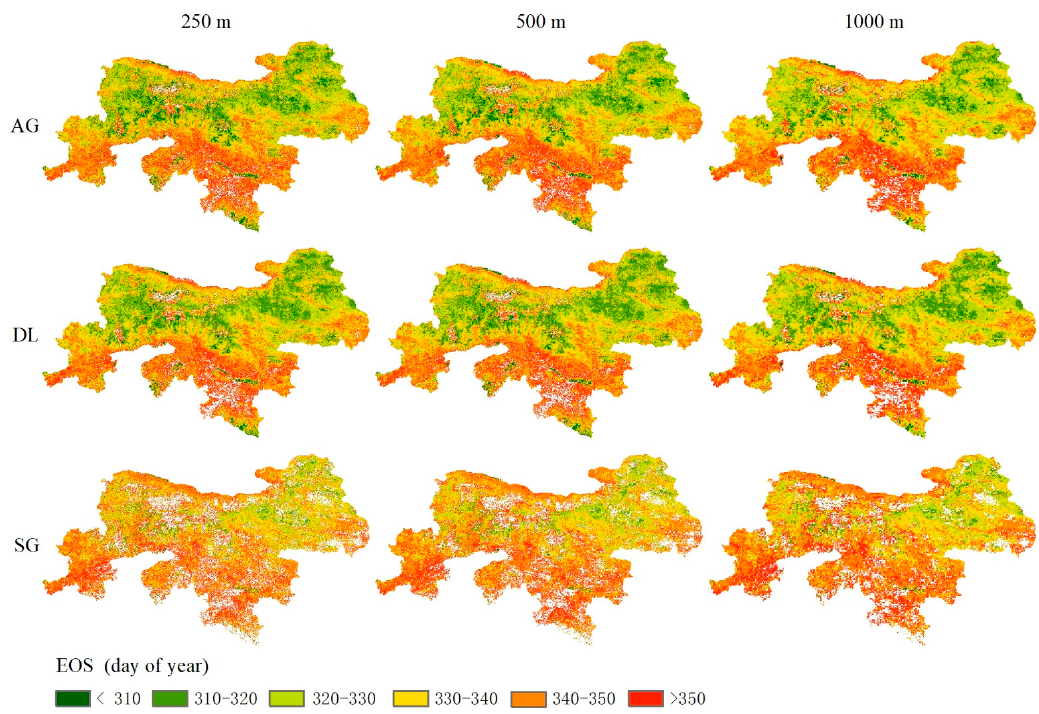
Figure 7. End of season (EOS) in 2018 retrieved from three different NDVI datasets (MOD13Q1, MOD13A1, and MOD13A2) and pre-processed with three different filters (SG, Savitzky-Golay; AG, asymmetric Gaussian; DL, double logistic).